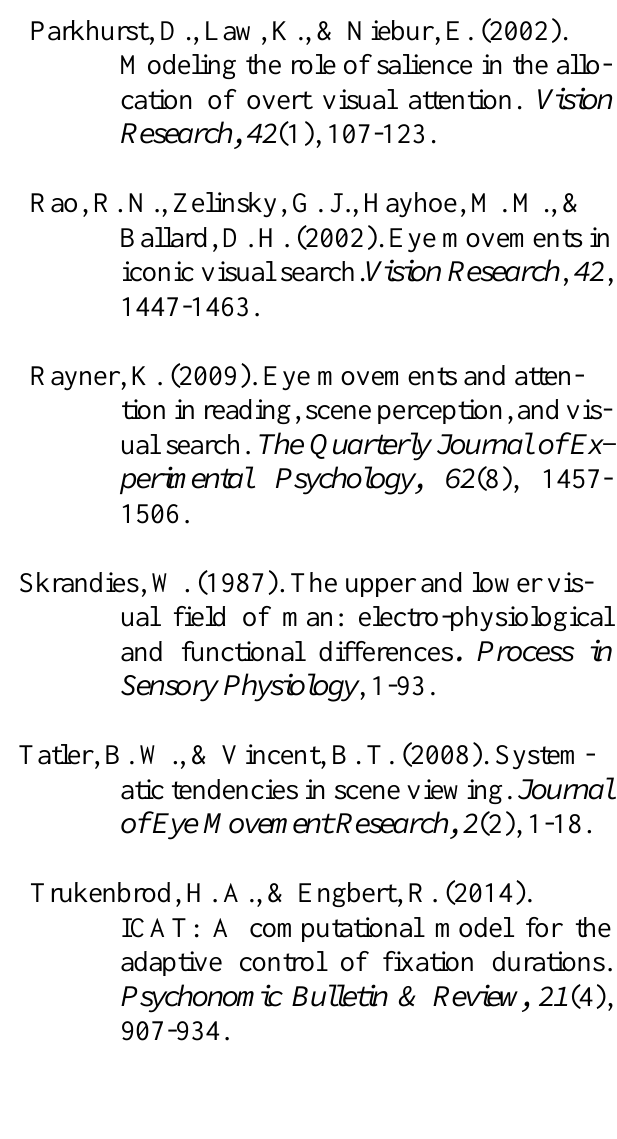
Functional differences in visual search fixation